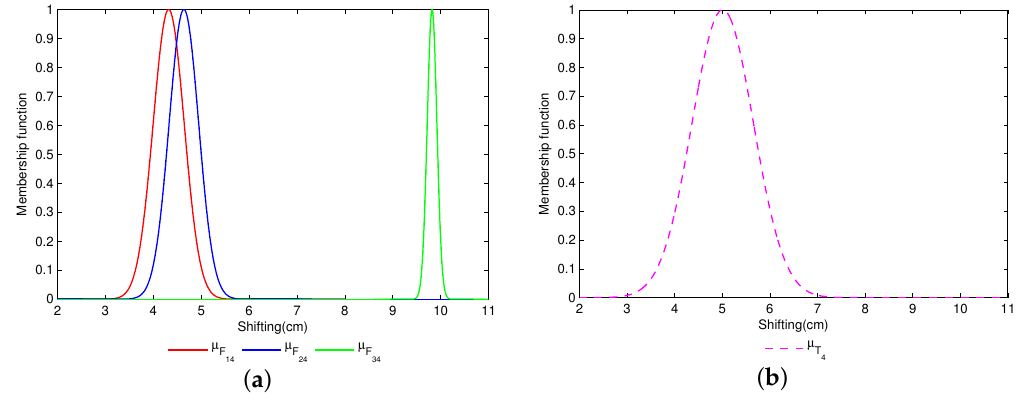
Figure 4. Generated fault models µ F models µ F ( i = 1, 2, 3); ( b ) shows the generated test model µ T i 4 Table 5. Mean value and standard deviation of µ F